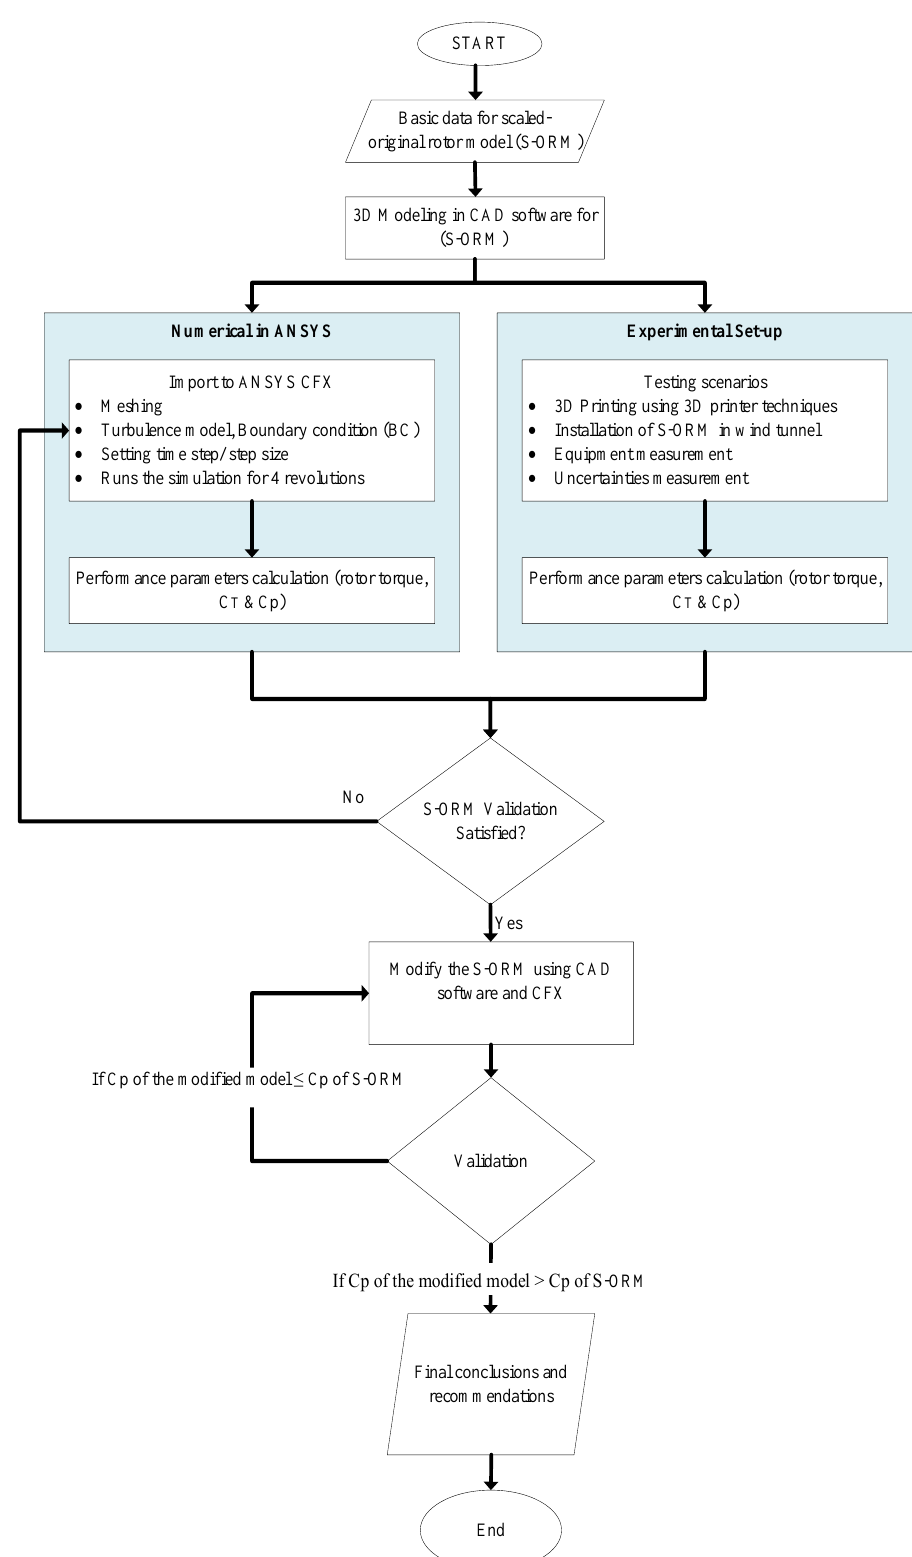
Figure 2. Flow chart detailing the procedure steps for the experiment and simulation in the study.